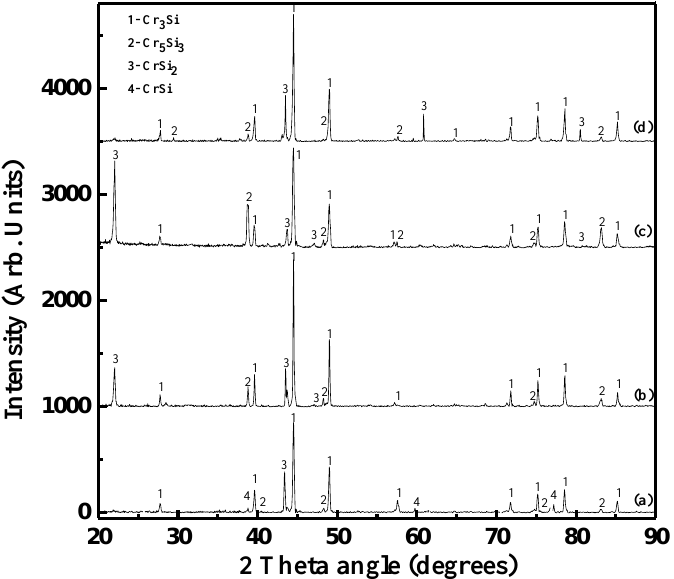
Figure 4. XRD pattern of the chromized sample obtained by 40 wt.% Cr in the pack mixture for 120 min at ( a ) 1000 °C; ( b ) 1050 °C; ( c ) 1100 °C; ( d ) 1150 °C. The peaks were indexed by use of PDF #75-2250 (Cr 3 Si), #51-1357 (Cr 5 Si 3 ), #35-0781 (CrSi 2 ), and #51-1356 (CrSi) [34].